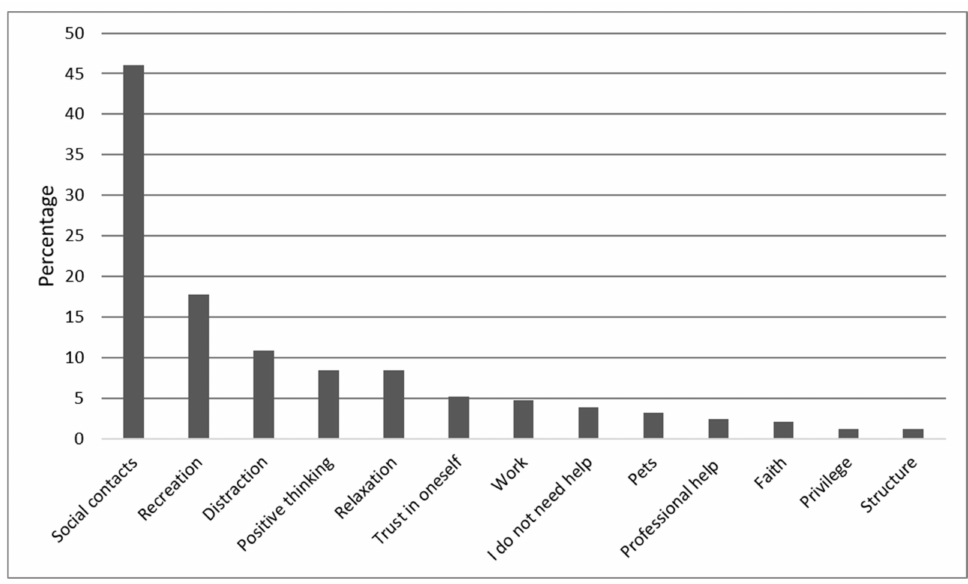
Figure 5. Sources of greatest current support. The percentages of participants reporting each main category of response that emerged from the data for the fourth question: “What is currently providing you with the most